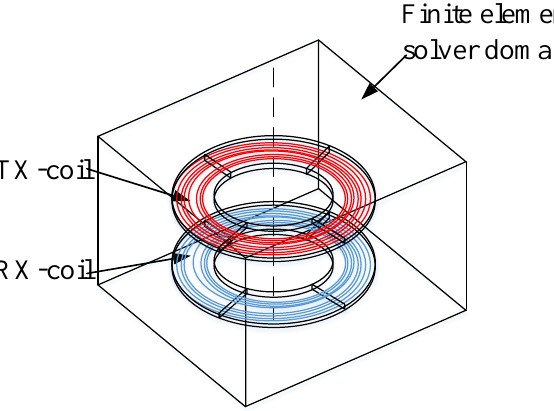
Figure 2. Schematic of simulation model. (The solver domain is larger than that shown in the figure). Table 1. The detailed parameters of the simulation. Parameter